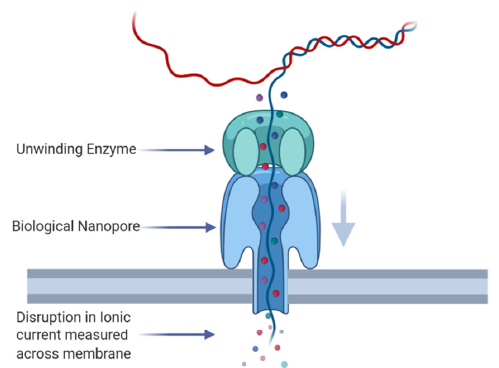
Figure 1. Stylized representation of Nanopore’s sequencing mechanism. Biological nanopores are embedded in a membrane. Double-stranded DNA is enzymatically unwound and the resulting ssDNA passes through the nanopore, disrupting the ionic flow through the nanopore in a characteristic manner dependent on the nucleotide bases within the